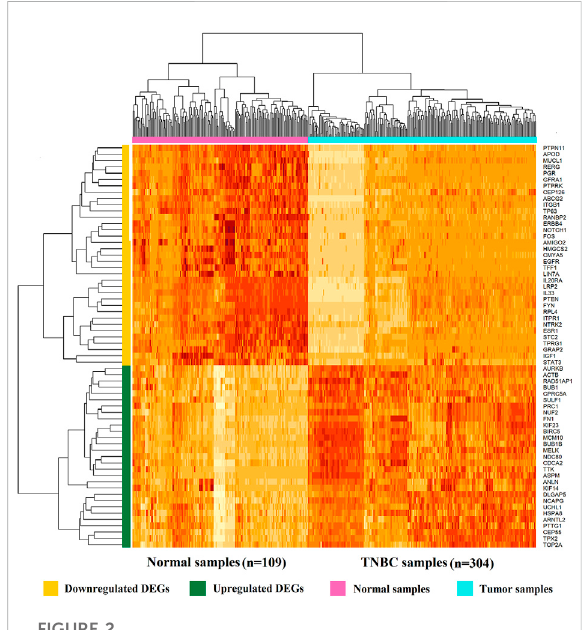
FIGURE 2 Heatmap of 64 identi fi ed DEGs based on integrated microarray analysis of fi ve datasets. Each row represents a single gene, and each column represents a tissue